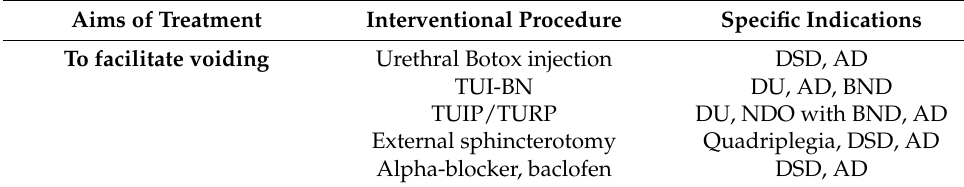
Table 2. Interventional management and surgical procedures for neurogenic lower urinary tract dysfunction in chronic spinal cord injured patients to facilitate spontaneous